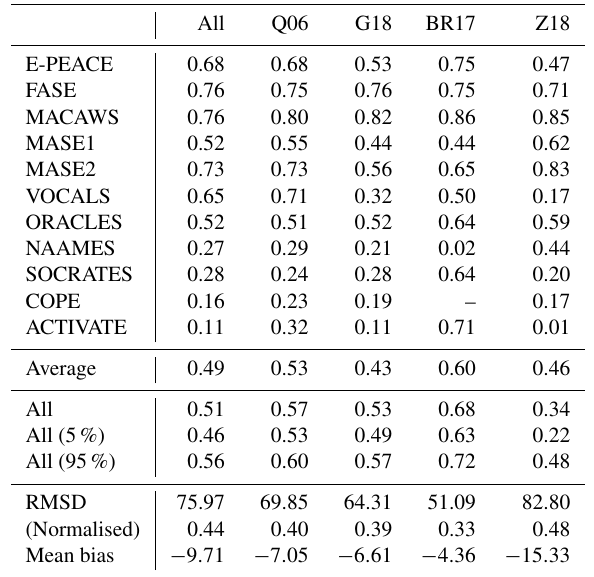
Table 2. Coefficient of determination ( r 2 ) for MODIS in situ com- parisons for the 2.1µm retrieval. “–” indicates too few points to cal- culate a correlation. The “Average” row is the average r 2 across the campaigns, and the “All” row is the r 2 value for all the valid data points across all campaigns (with 5% and 95% bounds). The bottom rows show the root mean squared deviation (RMSD), the RMSD normalised by the mean N d and the mean bias (MODIS– in situ) across all the campaigns. Numbers of data points for each campaign are shown in Fig. 6.